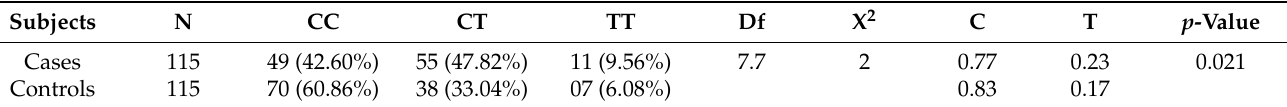
Table 9. Association of miR-196a-2 rs11614913 (C > T) gene variation in PCOS cases and